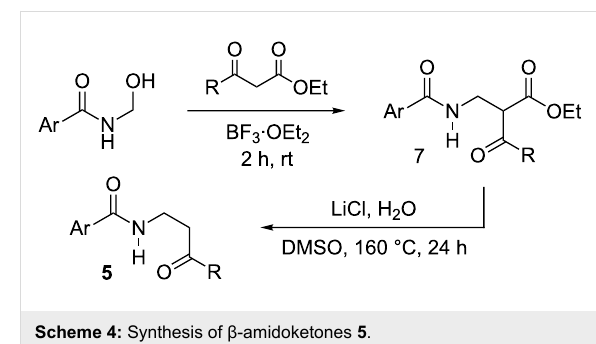
Scheme 3: Postulated mechanism for N -propargylamide cyclization.